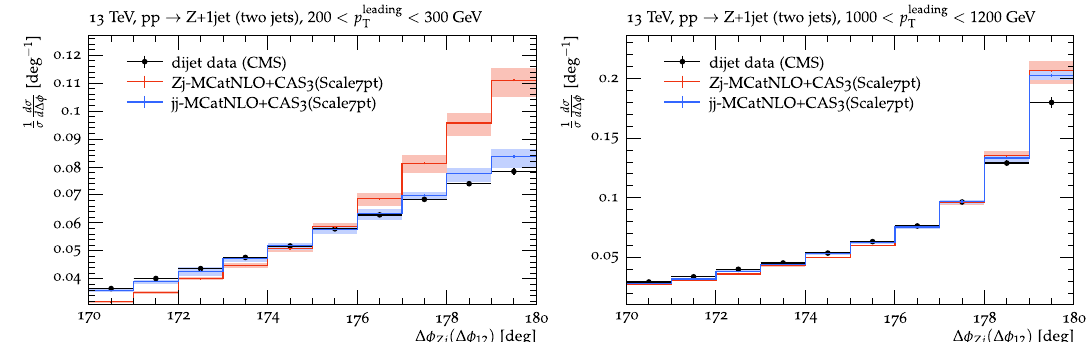
Fig. 3 Predictions of the azimuthal correlation (cid:2)φ Zj ( (cid:2)φ 12 ) for Z + jet MCatNLO+CAS3. Shown are the uncertainties obtained from scale variation (as described in the text). The measurements of dijet correla- > and multijet processes in the back-to-back region for p leading T tions as obtained by CMS [28] are shown as data points, for comparison > 1000 GeV (right) obtained from 200 GeV (left) and p leading T